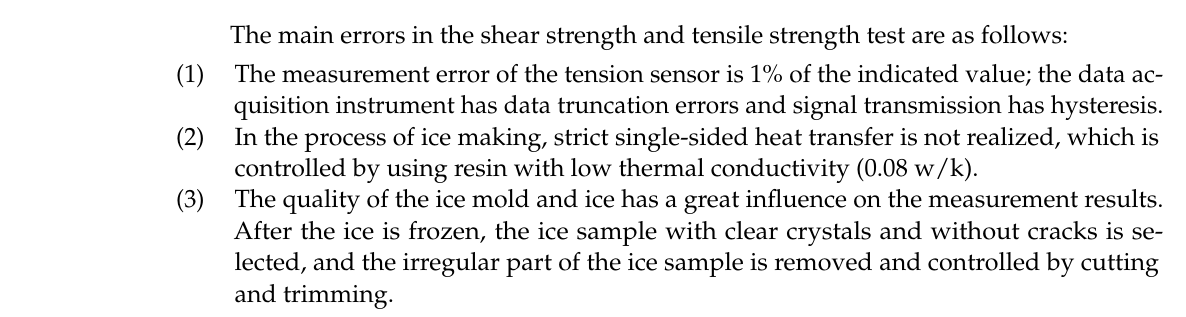
Table S9: Fuzhou Seawater Tensile Test Data; Table S10: Zhuhai Seawater Tensile Test Data. Author Contributions: Conceptualization, Y.Z. (Yongjie Zhang) and Y.Z. (Yunhui Zhang); method- ology, Y.Z. (Yongjie Zhang) and Y.Z. (Yunhui Zhang); software, Y.Z. (Yunhui Zhang); validation, Y.Z. (Yunhui Zhang) and R.G.; formal analysis, Y.Z. (Yongjie Zhang), Y.Z. (Yunhui Zhang) and